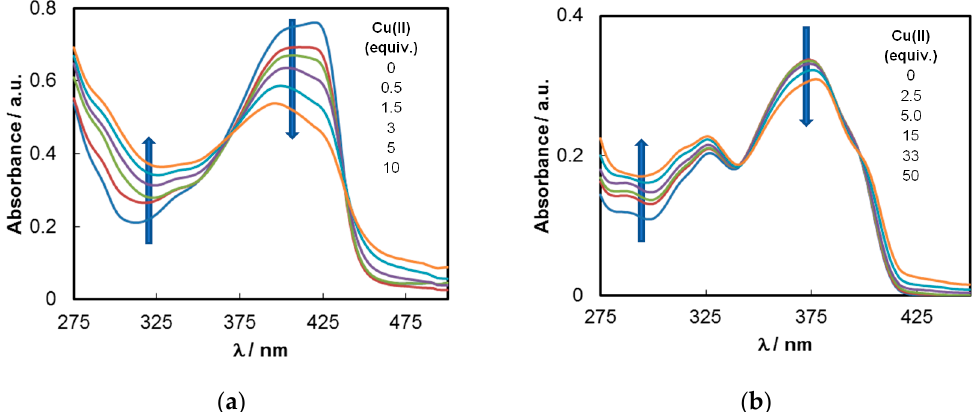
Figure4. Absorptionspectraof( a )polymer 5 (8.2 × 10 − 5 MinCH 3 CN:CHCl 3 ,1:1)and( b ) Calix-OCP-2-CBZ (5.0 × 10 − 6 M in CH 3 CN) upon addition of increasing amounts of Cu(ClO 4 ) 2